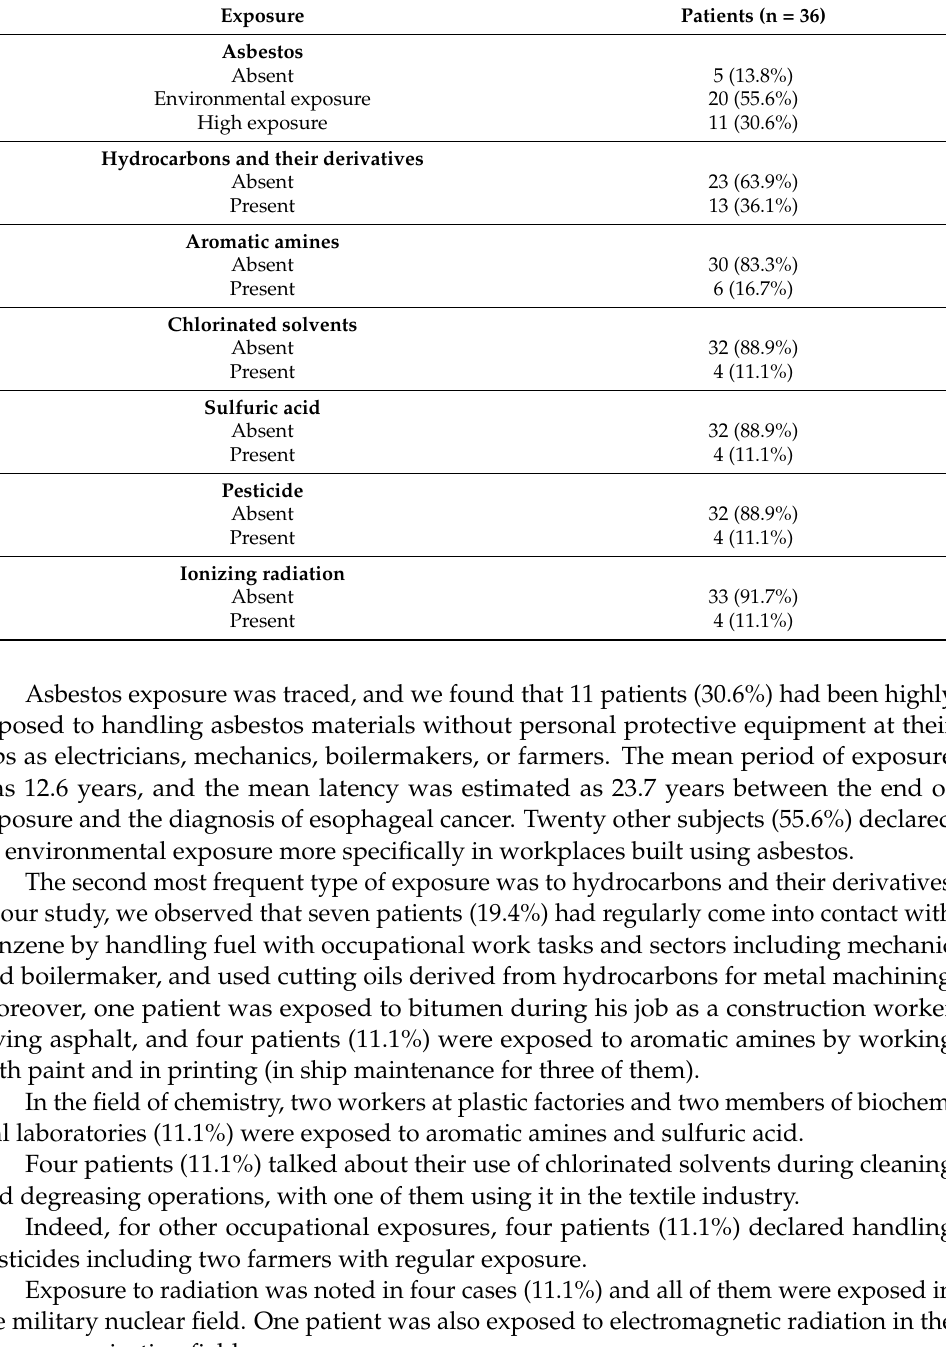
Table 2. Data analysis of included patients’ occupational